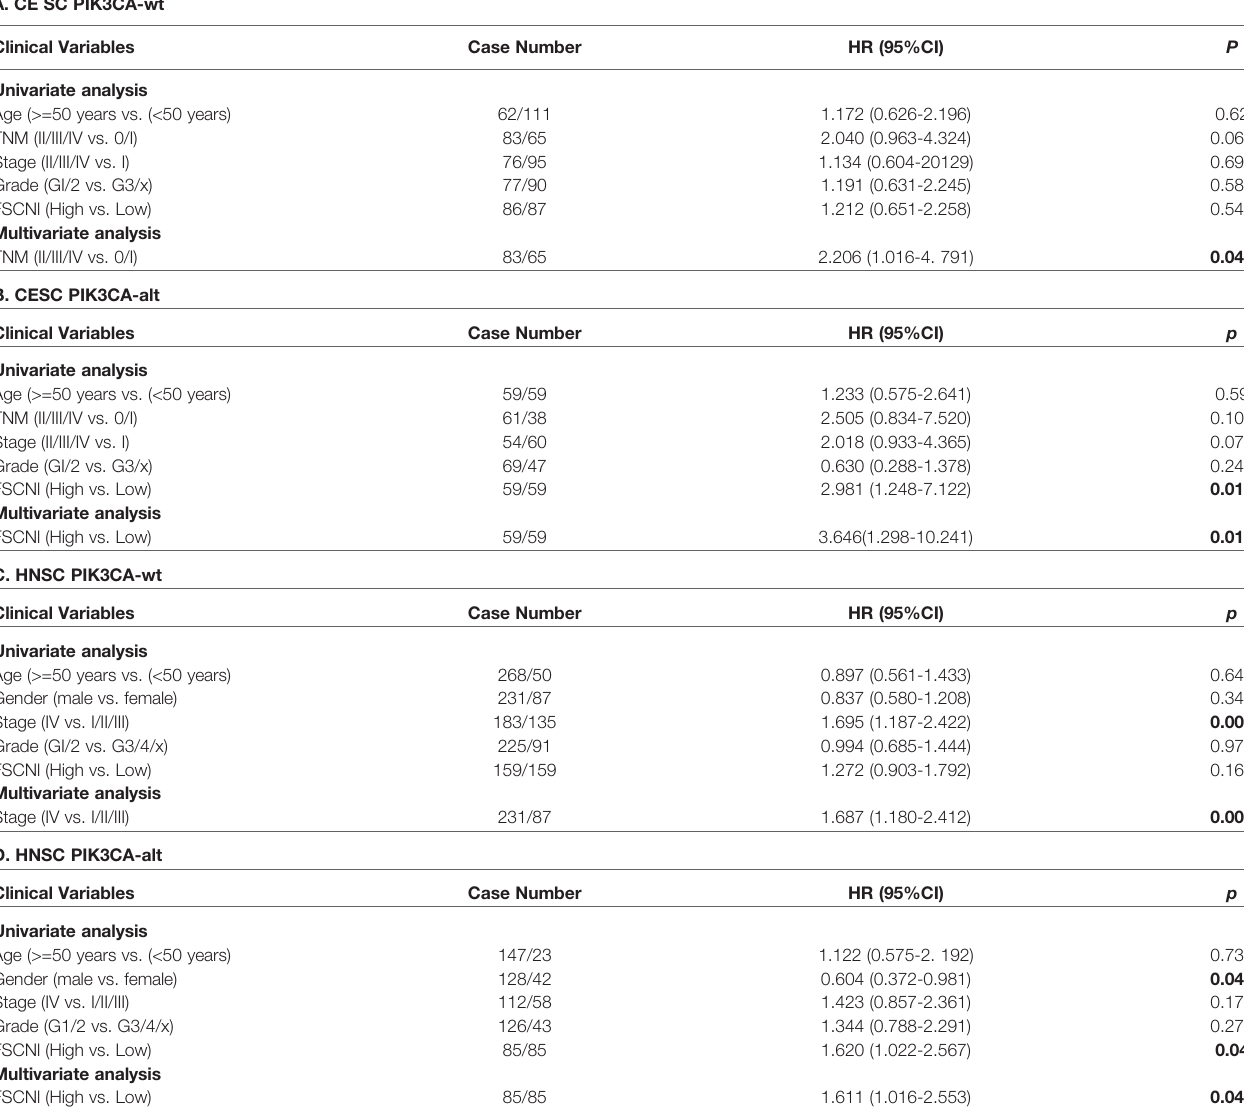
TABLE 1 | Univariate and multivariate analysis of factors associated with overall